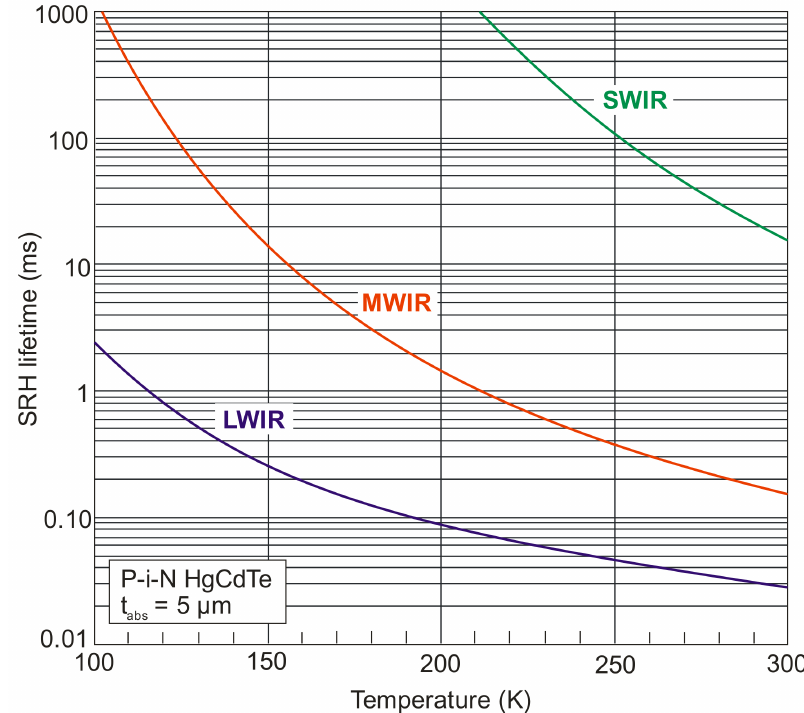
Figure 6. The SRH lifetime versus temperature where fully depleted P-i-N HgCdTe detector depletion dark current equals the background radiation current. The calculations were carried out for SWIR (3 µ m), MWIR (5 µ m), and LWIR (10 µ m)